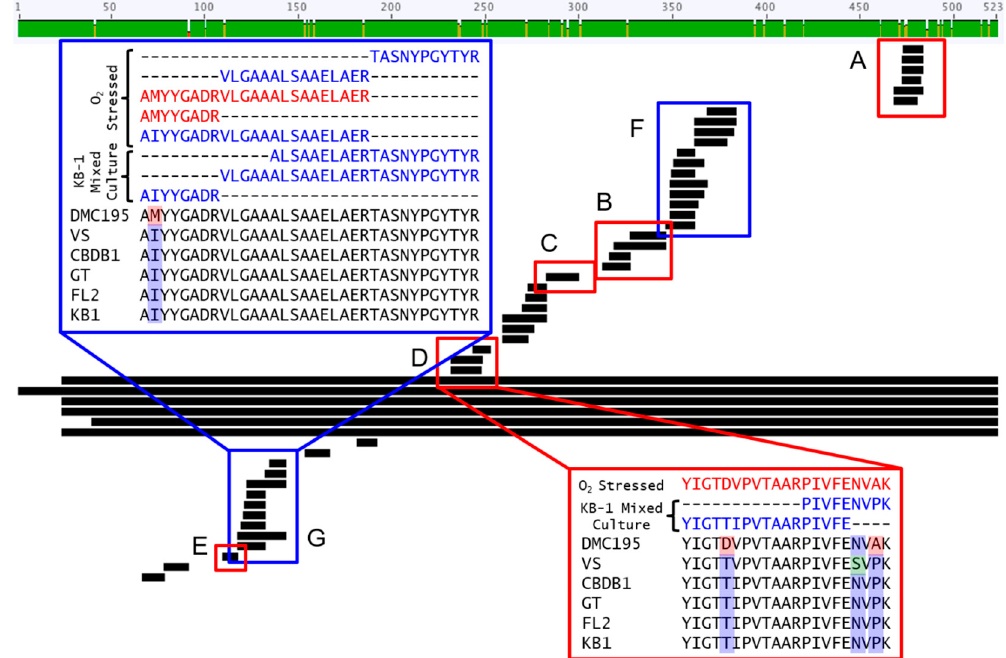
Figure 2. A comparison of RDase DET1545-homolog peptides (short black bars) detected in the KB-1 culture sample and oxygen stressed KB-1 culture to the full length 1545-homolog sequences in DMC genomes in different groups: 1545-Cornell (DMC195), 1545-Victoria (DMC strain VS), and 1545-Pinellas (DMC strains CBDB1, GT, FL2, and the KB-1 mixed culture). Peptides boxed in red ( A – E ) show strain specificity, whereas peptides boxed in blue ( F , G ) are highly conserved and align across all strains. In the insets, amino acid residues where variation occurs are highlighted in red if specific for DMC195, green if specific for VS, or blue if not strain-specific. This figure was created using Geneious version 5.0.4 created by Biomatters.